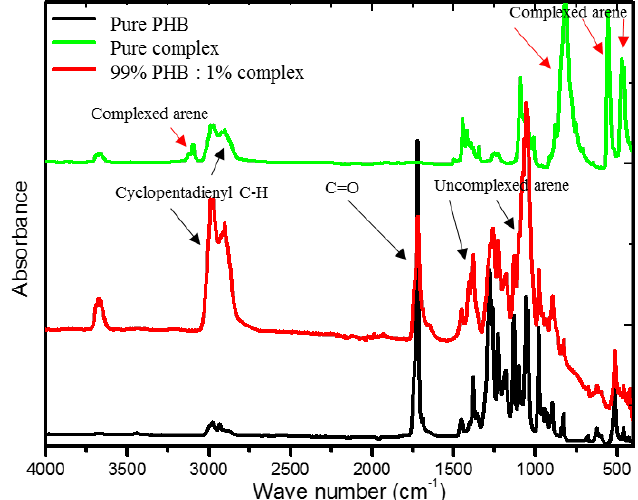
Figure 3. FTIR spectra of the CpFe + complex, pure PHB, and PHB/ CpFe + nanocomposites.